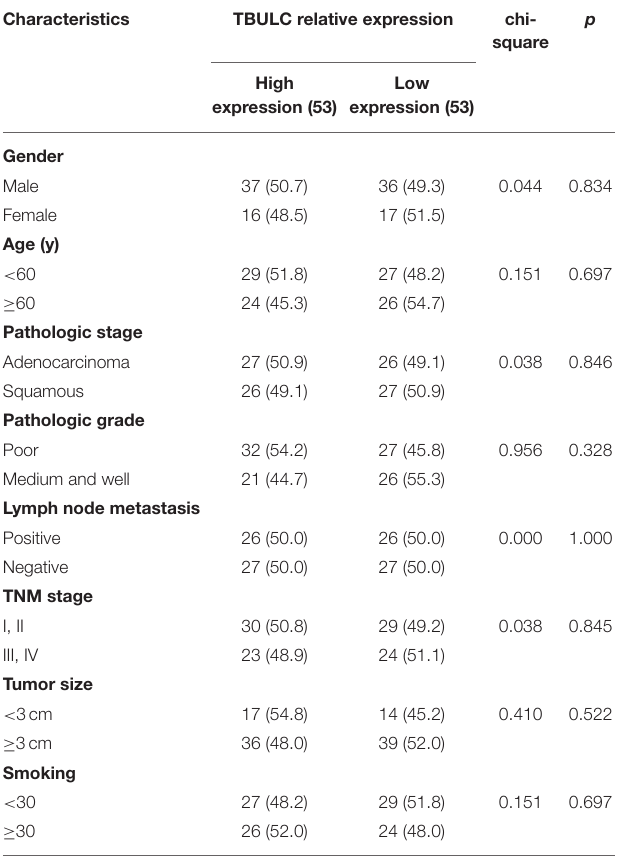
TABLE 1 | Correlations between clinicopathological features and the expression level of TBULC.